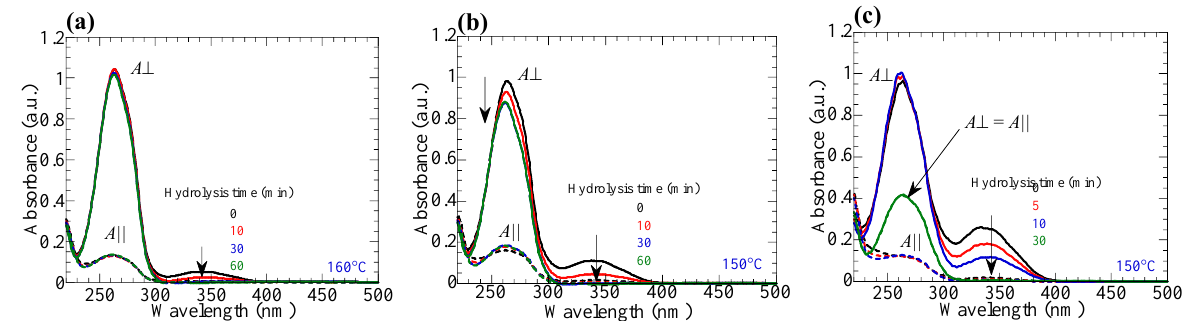
Figure 10. Changes in the polarized absorption spectra when oriented ( a ) PN10 , ( b ) PN20 , and ( c ) PN50 films are annealed at 160 °C ( PN10 ) or 150 °C ( PN20 , PN50 ) under RH = 100 % atmosphere.